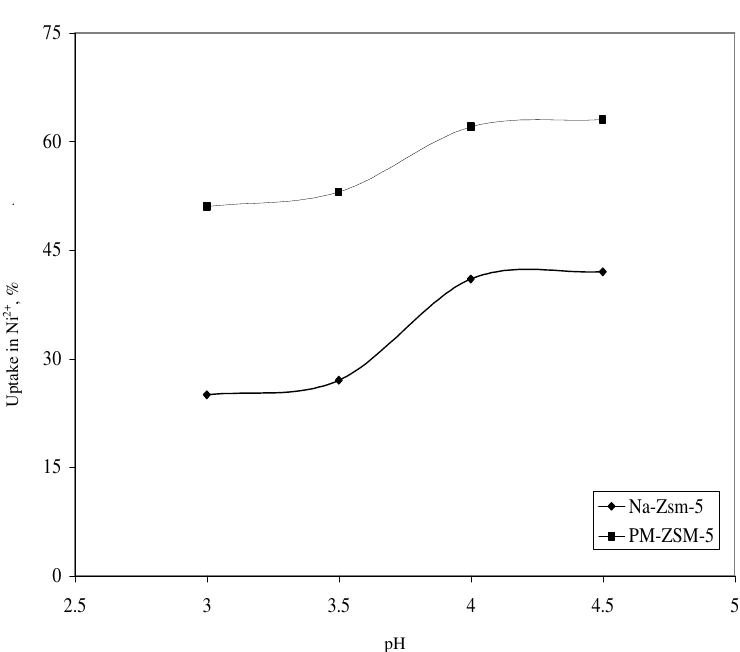
Figure 4. Effect of pH in Ni 2+ ions from aqueous solutions onto ( ♦ ) Na-ZSM-5 and ( ■ )PNa ZSM-5